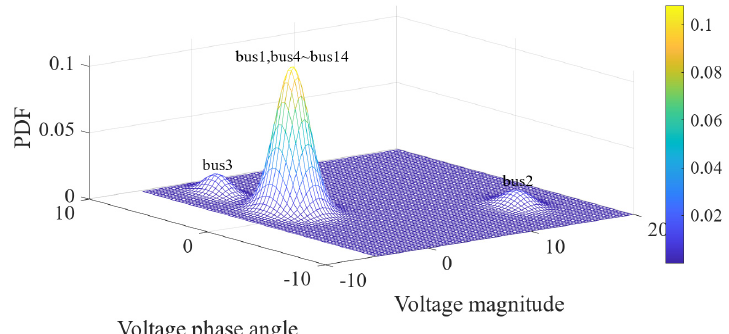
Figure 21. PDF of state estimation errors.